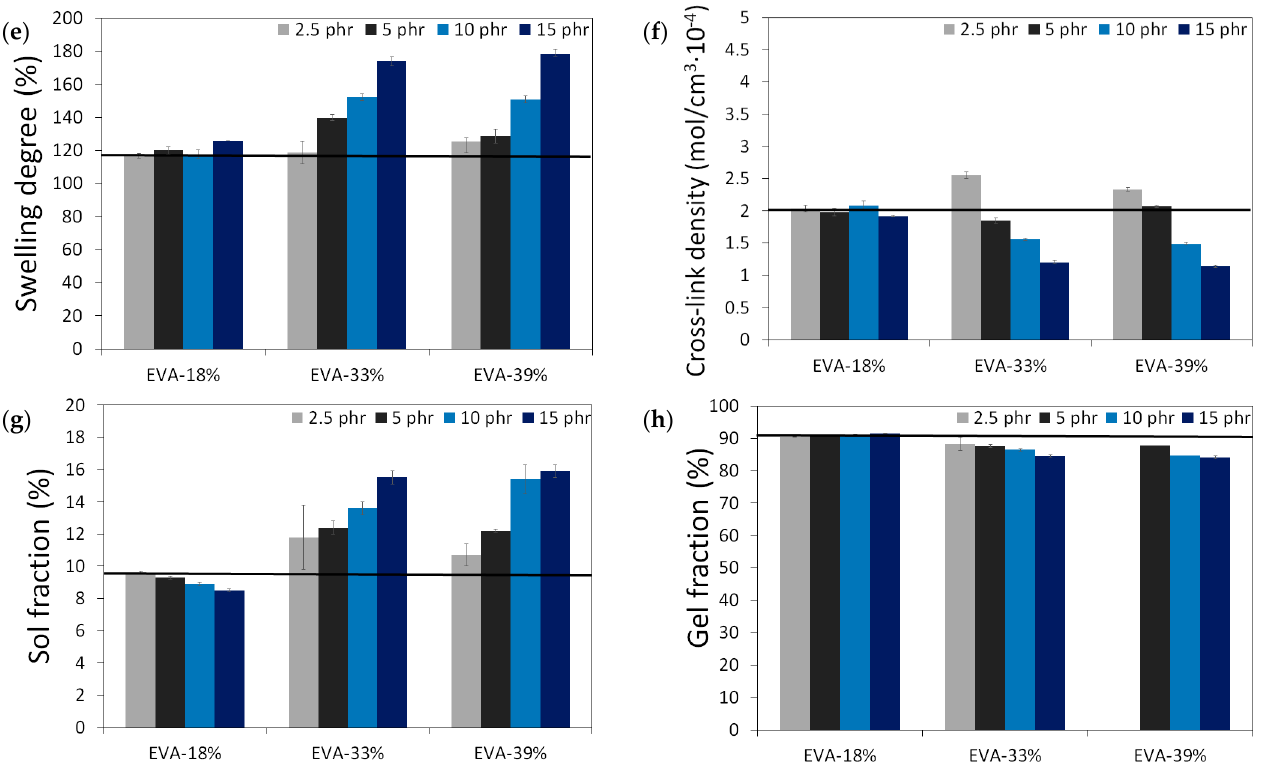
Figure 4. Physico-mechanical properties of modified GTR (black line represents sample with EVA): tensile strength (MPa) ( a ); elongation at break (%) ( b ); hardness (Shore A) ( c ); density (g/cm 3 ) ( d ); swelling degree (%) ( e ), cross-link density (mol/cm 3 10 − 4 ) ( f ), sol fraction content (%) ( g ) and gel fraction content (%) ( h )